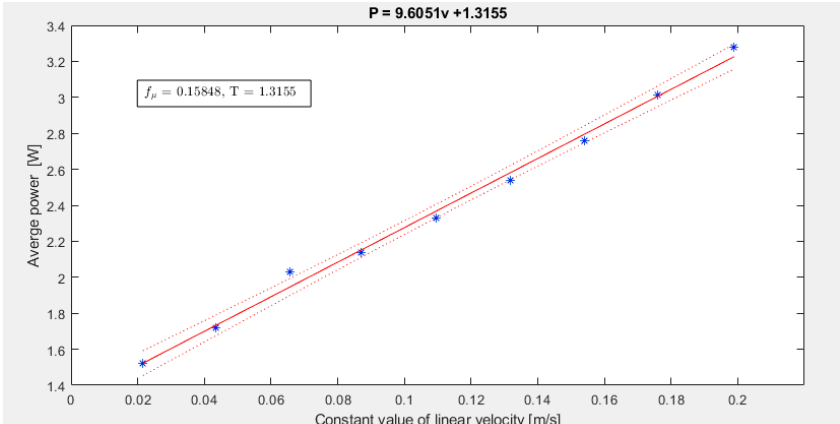
Figure 7. The calculation of parameters on the Floor panels.